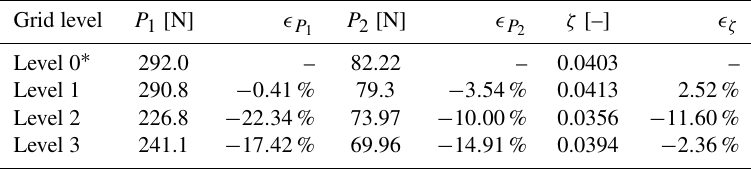
Table A1. Comparison of peaks and damping ratios for different grid levels.